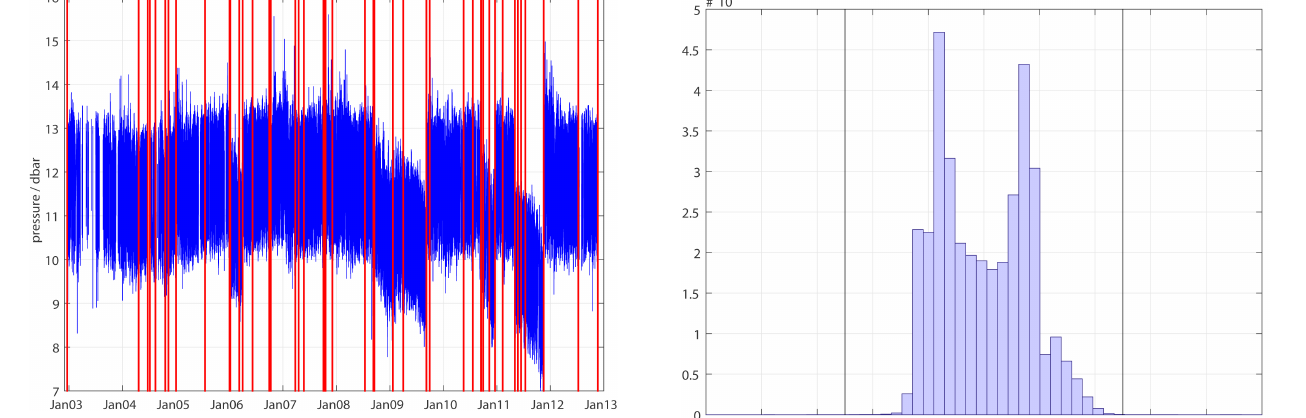
Figure 2. Measured water pressure data (blue) at the Time Series Station Spiekeroog before the validation and times of sensor main- tenance (red vertical lines). Figure 3.